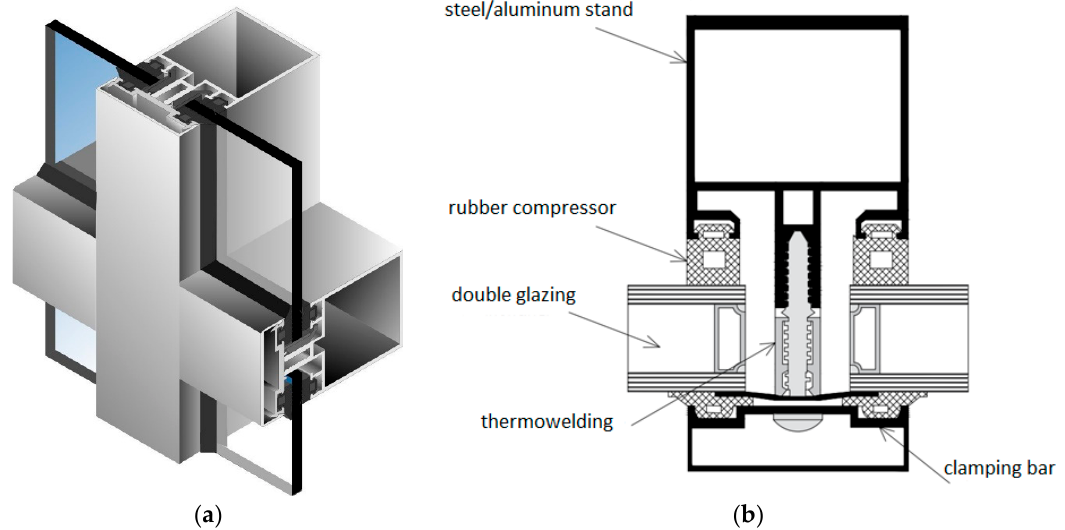
Figure 3. ( a ) Visual representation of the insulating glazing in the profile and ( b ) scheme of installation of the insulating glazing in the steel and aluminum profile.